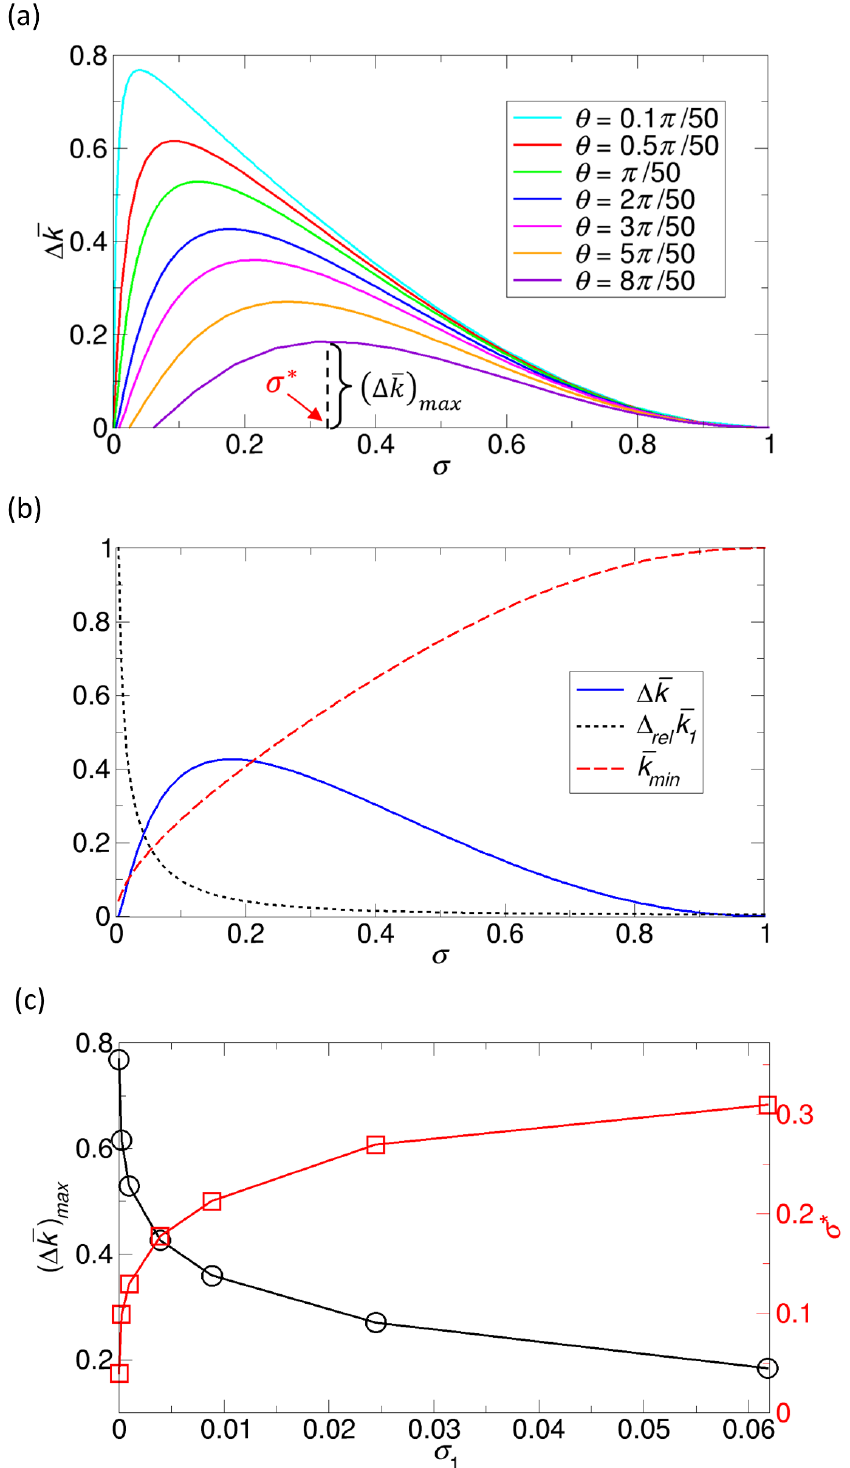
Figure 10. ( a ) Variation ∆𝑘̅ calculated from Equation (9) for the Northrup reaction systems as a function of the total reactive area fraction 𝜎 for patch sizes of 𝜃 = 0.1𝜋